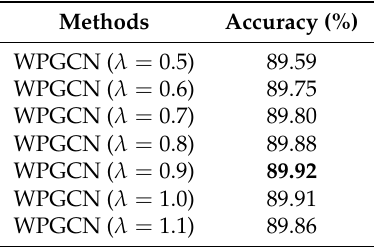
Table 4. Comparison of the recognition accuracy with different settings of the fusion parameters. The best result is shown in bold.